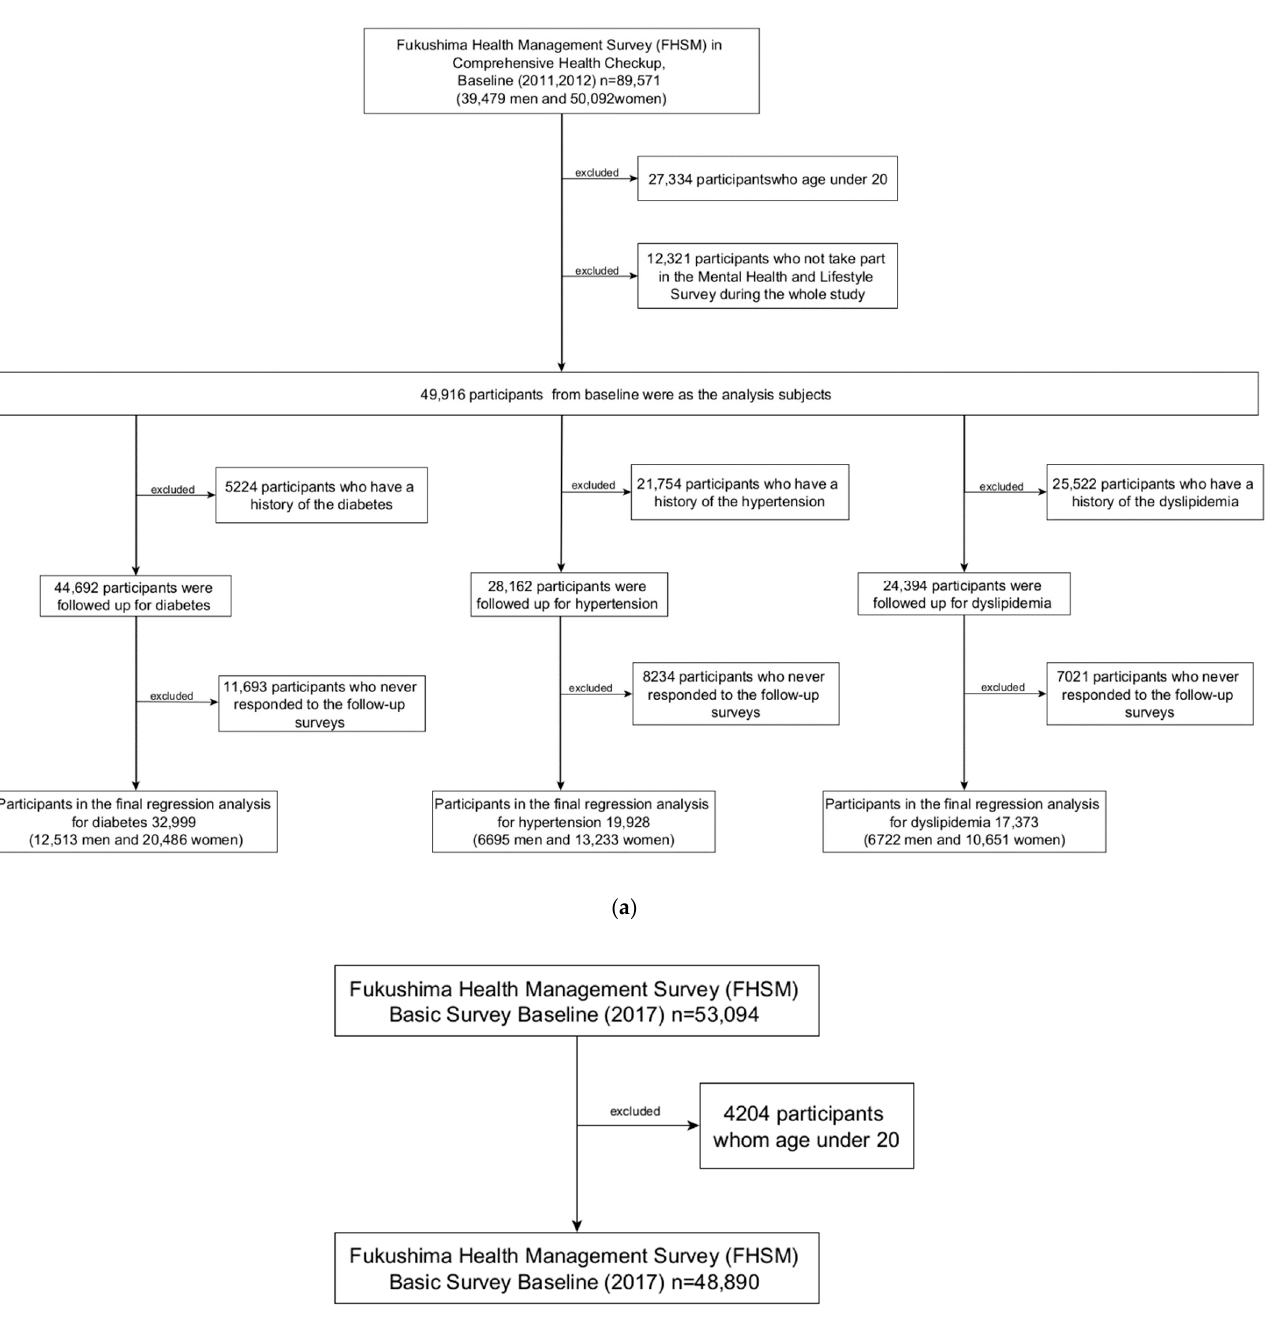
Figure 1. Flow diagram of the participant selection process: ( a ) longitudinal analysis; ( b ) spatial analysis.